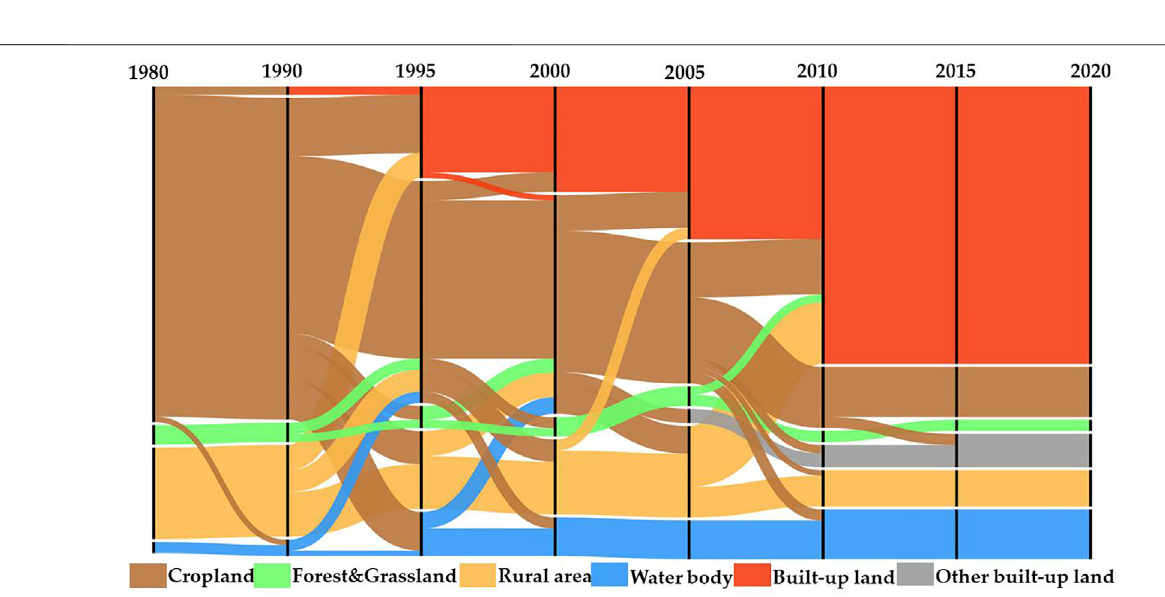
Frontiers in Environmental Science |